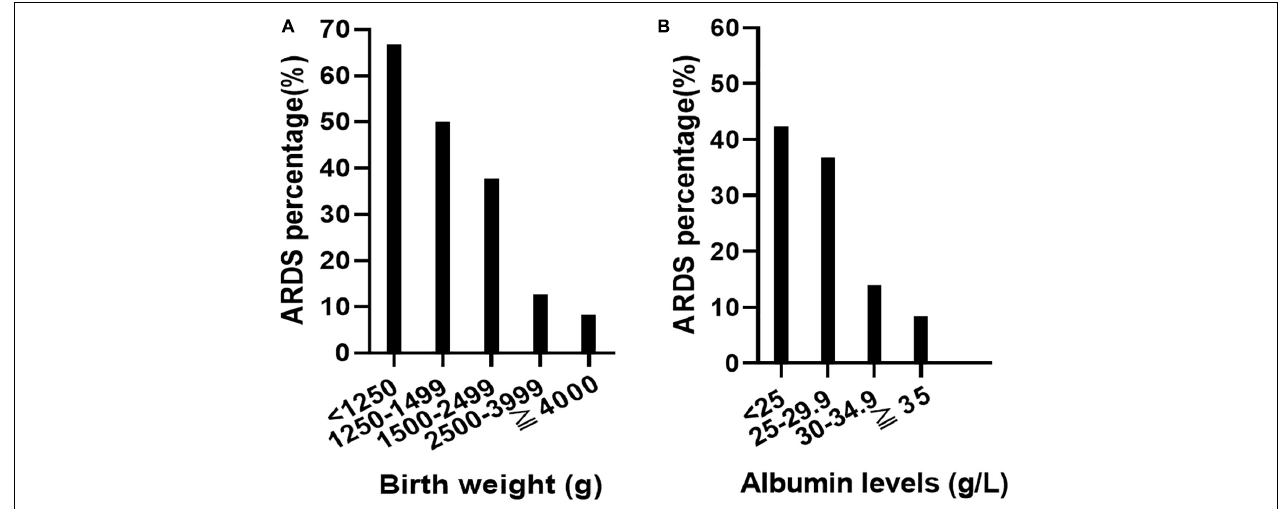
FIGURE 2 | Relationship between birth weight, serum albumin level, and the incidence of acute respiratory distress syndrome (ARDS). With the decrease of birth weight, the incidence of ARDS increased gradually (A) . With the decrease of plasma albumin level, the incidence of ARDS increased gradually (B) .